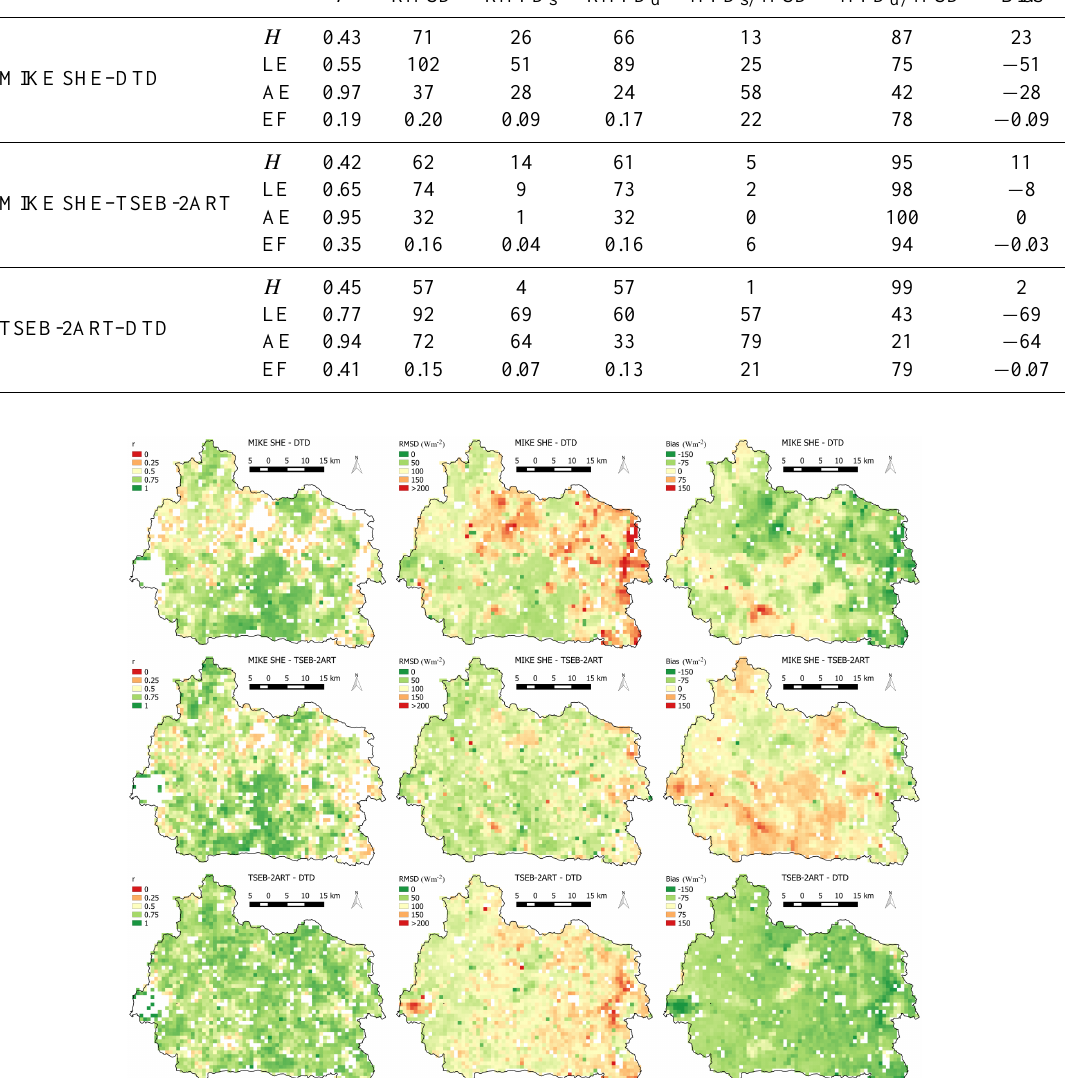
Figure 11. Maps of spatial patterns of correlation ( r – first column), RMSD (second column) and bias (third column) calculated with LE output of MIKE SHE–DTD (first row), MIKE SHE–TSEB-2ART (second row) and TSEB-2ART–DTD (third row) in the whole Skjern river catchment. For each pixel in the RMSD and bias maps a mean of the statistics’ values was taken from all the points satisfying the conditions stated in Sect. 5 (i.e. the same set of values was used as for producing statistics in Table 2 and density scatter plots in Figs. 2–4). Correlation maps used the same set of values but only the pixels where correlation was significant at 5% level are